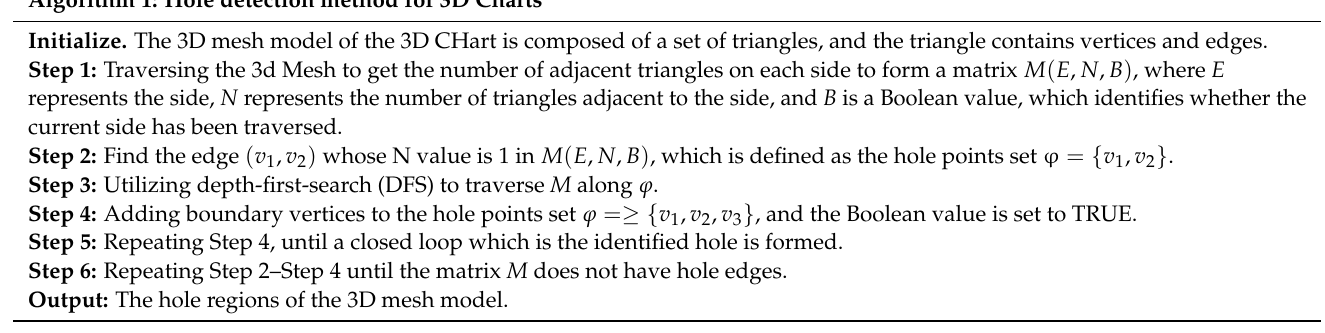
Figure 1. Several types of holes existed on the surface of 3D Charts. ( a ) is a simple closed hole formed by connecting the edges of the triangular mesh; ( b ) is a simple hole with a small number of independent triangular meshes in the hole closed by the edges of the triangular mesh; ( c ) is an unclosed complex hole; ( d ) is a simple hole in the scanning data obtained by the scanner. Algorithm 1: Hole detection method for 3D Charts